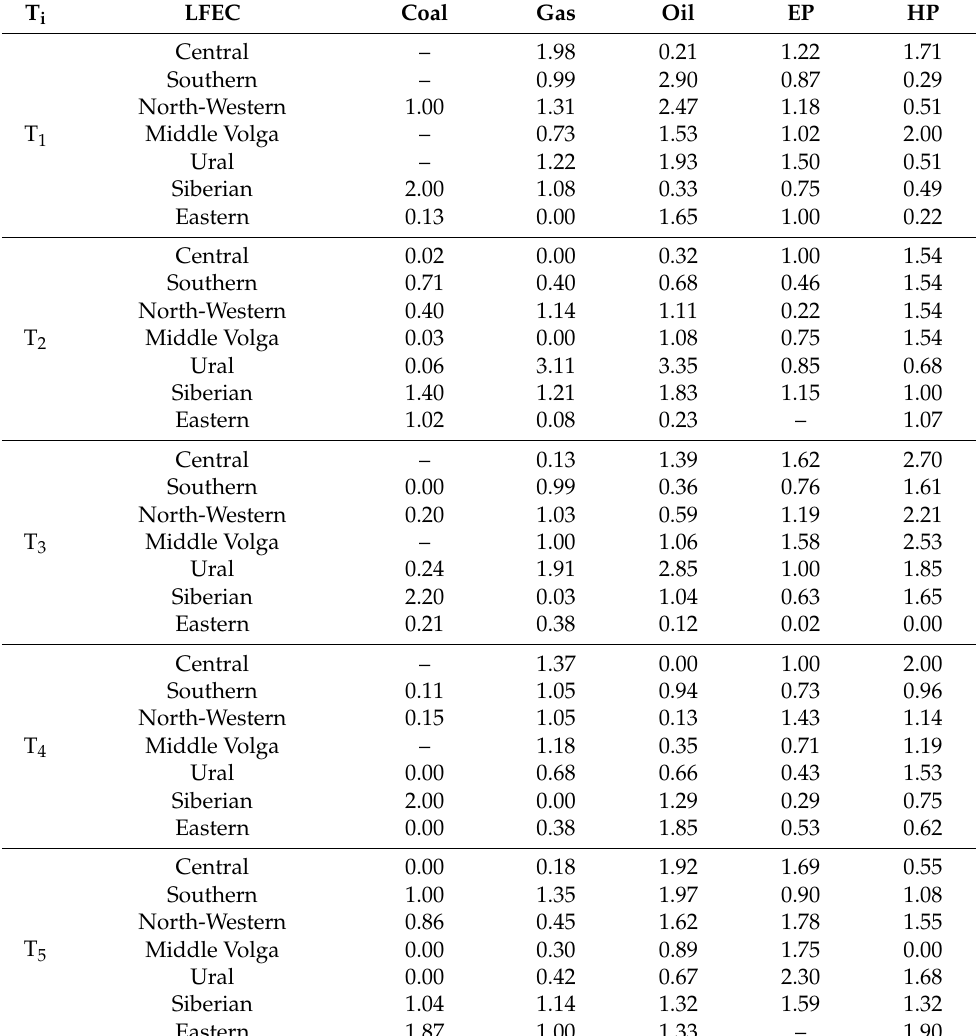
Table 1. Total value of the LFEC’s